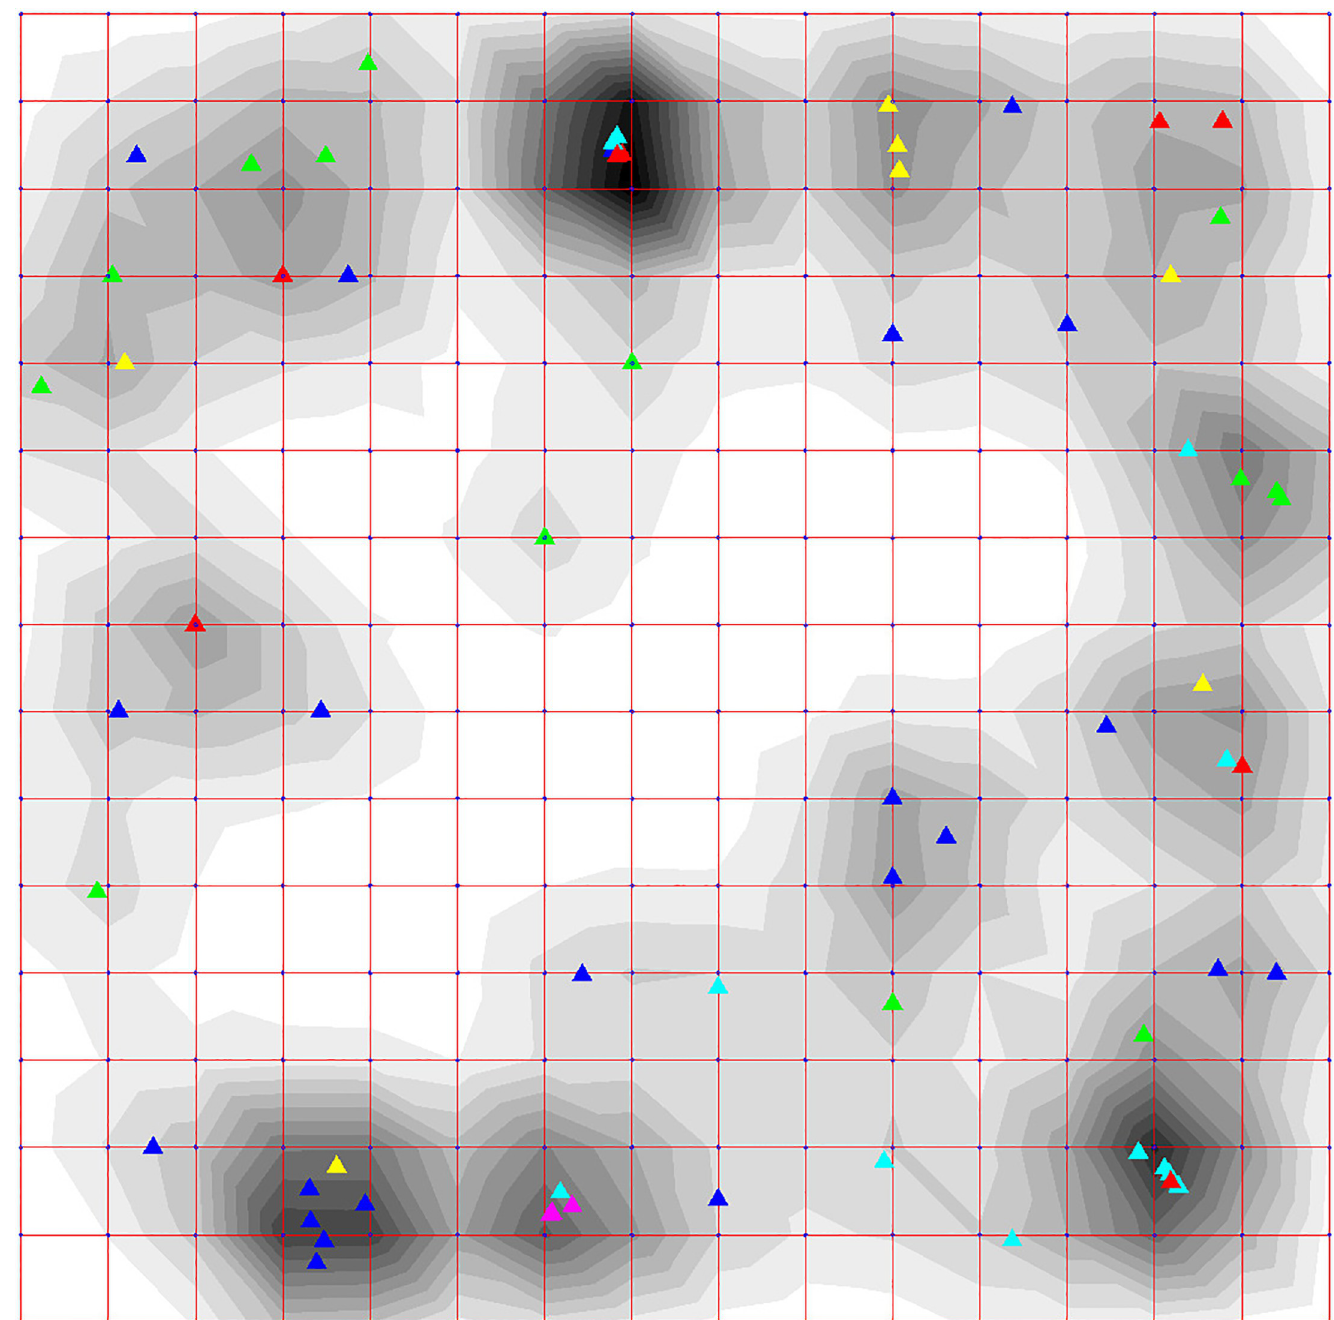
Fig 5. Elastic map of the 16 × 16 type in internal coordinates reflecting local density by shades of grey contours and demonstrating 69 coronavirus genomes depicted by differently colored triangle dots. Dark blue triangle dots depict viruses that cause disease in bats, red—respiratory disease in humans, light blue— respiratory disease in mammals, yellow—intestinal disease in mammals, pink—hepatitis in mice, and green—respiratory disease in birds.